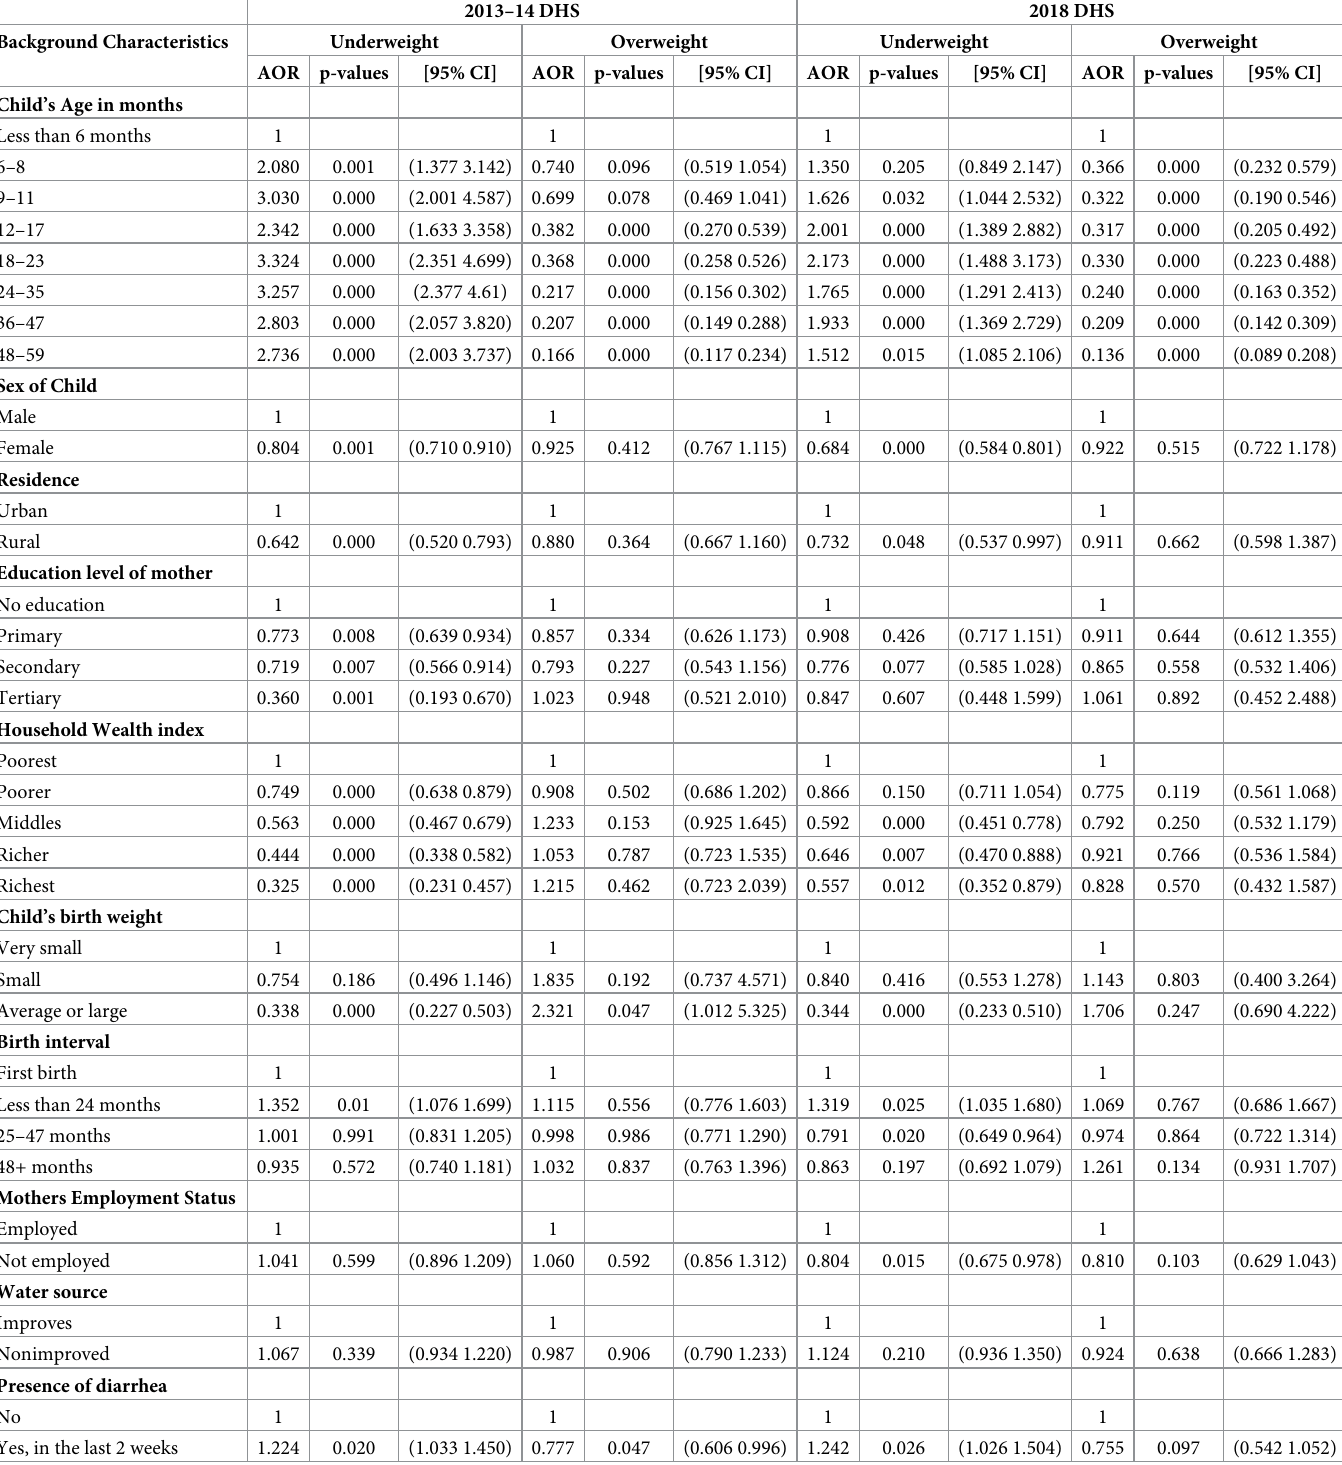
Table 4. Multivariate analysis of malnutrition indicators (Underweight and Overweight) for 2013/14 and 2018 DHS